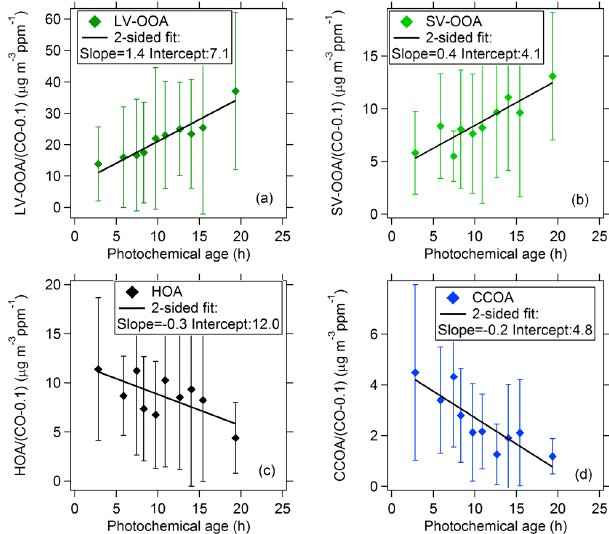
Fig. 13. The variations of (a) LV-OOA/ 1 CO (b) SV-OOA/ 1 CO (c) CCOA/ 1 CO (d) HOA/ 1 CO with photochemical age. The di- amond points and bars are the average values and their standard de- viations in each photochemical age bin. The lines are the regression results of the average values.